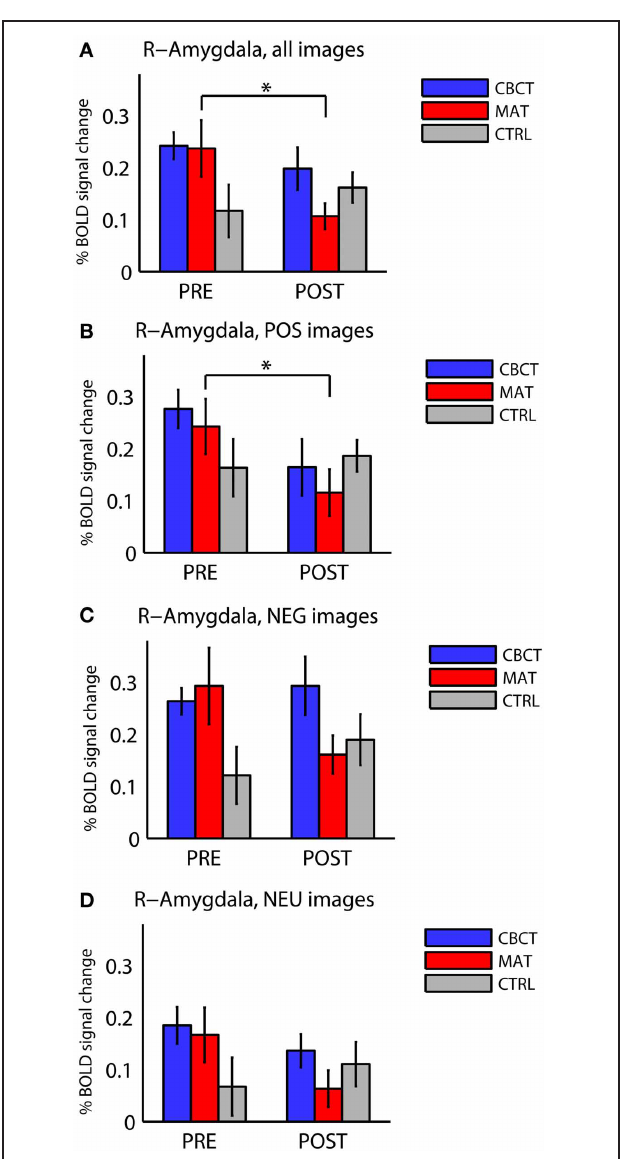
FIGURE 2 | Percentage BOLD signal change in right amygdala for all three groups of subjects (CBCT, MAT, CTRL), in the pre-intervention scan (PRE) and in the post-intervention scan (POST), (A) for images of all valences, (B) for images with positive valence (POS), (C) for images with negative valence (NEG), and (D) for images with neutral valence (NEU). The asterisks indicate statistically significant differences between PRE and POST (two-tailed paired t -tests, p < 0 . 05). Bars represent mean ± standard